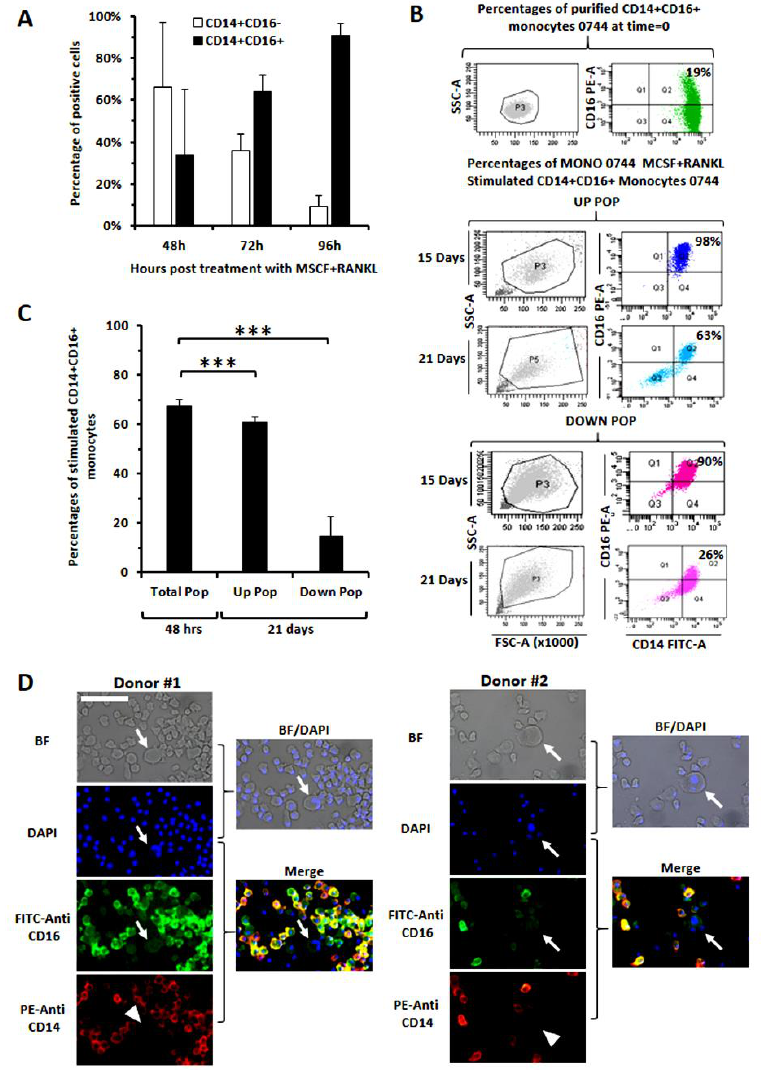
Figure 5. Evaluation of up-regulation and preservation of CD16 during transitional stages of monocyte differentiation toward osteoclasts. ( A ) Factors promoting osteoclast differentiation in vitro (MCSF + RANKL) strongly increased the percentage of CD16+ monocytes within 72–96 h of exposure. Data are means of monocytes derived from three different donors. ( B ) CD16 was highly expressed in both UP (smaller) and DOWN (larger) populations after 15 days of stimulation and resulted instead in significantly decreased only in the DOWN population at later times. ( C ) Analysis of CD16 expression in UP and DOWN population as evaluated in monocytes from three different donors. ( D ) Images display strong CD16 positivity in a large number of small monocytes and a weaker expression in osteoclasts (frankly tri-nucleated as indicated by arrows) which also have down-regulated CD14 (arrow-heads). Images are representative of monocytes from 2 healthy donors studied after 15 days of classical stimulation with MCSF + RANKL. All images were acquired at the same enlargements (bar: 6 µm).